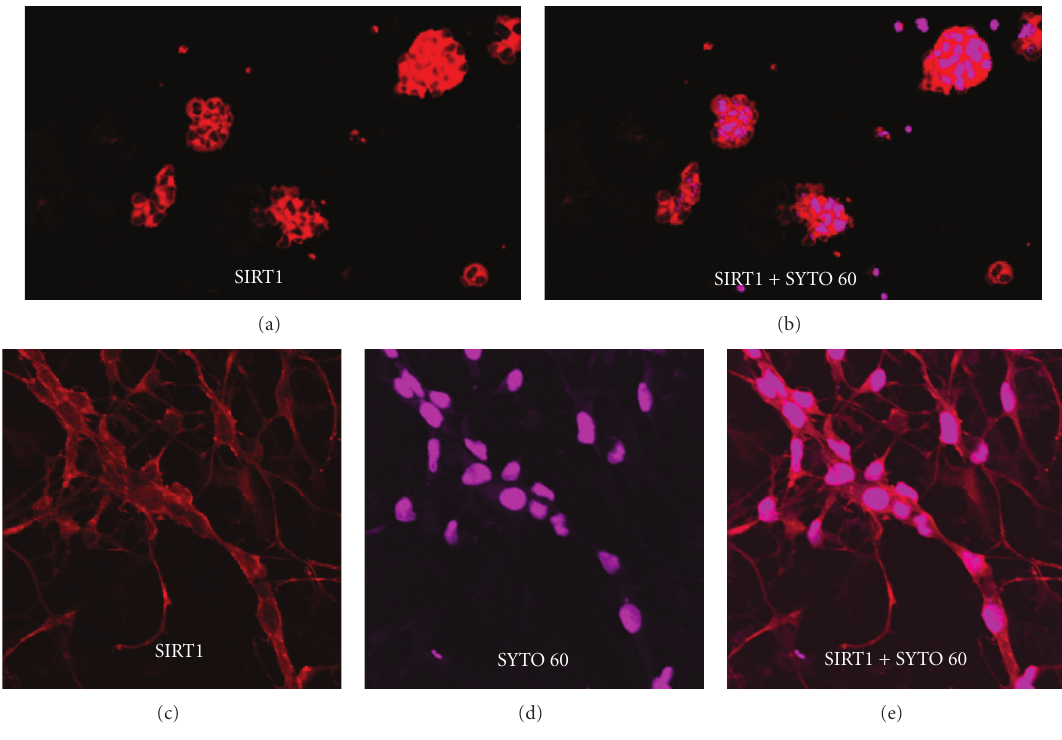
Figure 3: Expression of SIRT1 in mouse retinal progenitor cells. (a) SIRT1 positivity (red) seen throughout neurosphere. (b) Composite image showing SIRT1 staining (red) and SYTO 60 nuclear staining (magenta). (c) Expression of SIRT1 (red) in di ff erentiated mRPCs. (d) SYTO 60 nuclear stain (magenta). (e) Composite of (c) and (d) showing cytoplasmic expression of SIRT1 in di ff erentiated